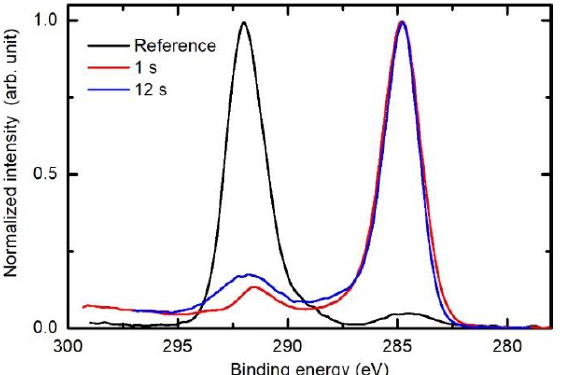
Figure 9. Comparison of XPS high-resolution C1s spectra of the untreated PTFE, and PTFE exposed to H 2 plasma for 1 and 12 s. The discharge power and the pressure were constant at 400 W and 25 Pa, respectively.